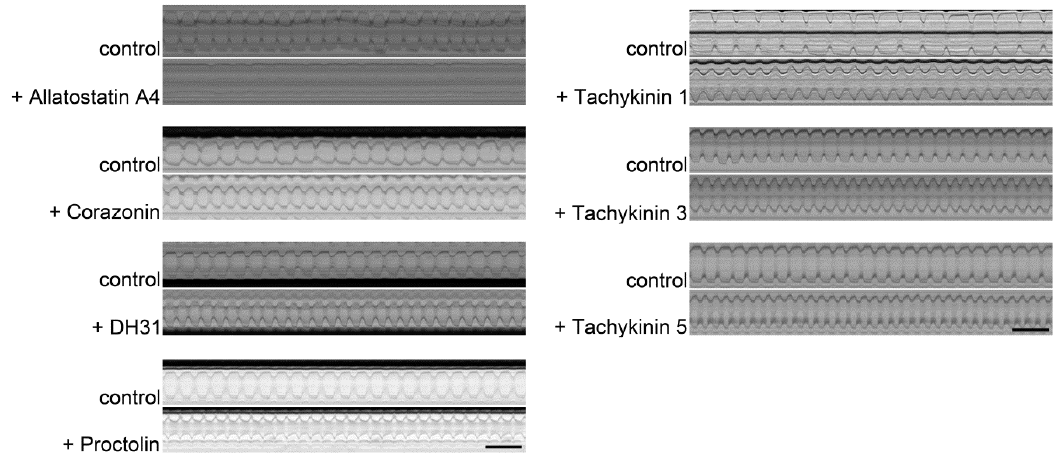
Figure 4. Representative M-modes of semi-intact larval Drosophila hearts incubated with distinct peptides (1 × 10 − 7 M). The movement of the heart walls over time (10 s) is depicted. Application of Corazonin, DH31, Proctolin, or Tachykinins 1, 3, or 5 has a cardioacceleratory effect. Application of Allatostatin A4 results in cardiac arrest. Upper panels represent control hearts (prior to peptide application); lower panels depict the same hearts 1 min after peptide application. Scale bars indicate 1 s.